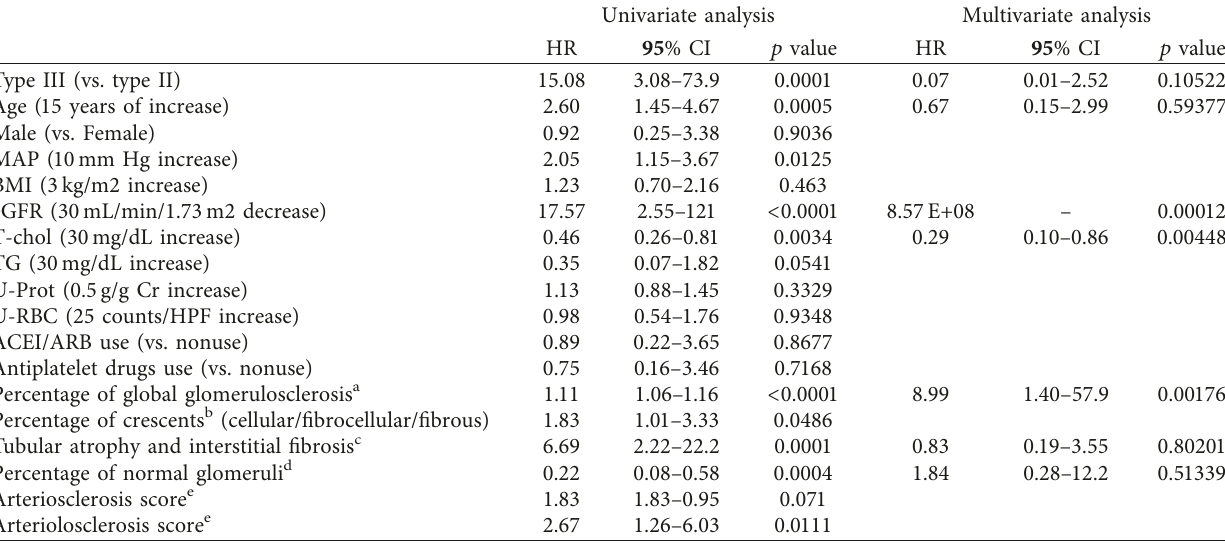
Figure 1: One-year renal survival in patients with type II and type III glomerulonephritis and crescents. Analysis of the 1-year survival rate using the Kaplan–Meier method shows that the renal prognosis of patients with type III glomerulonephritis and crescents was significantly worse ( p 0 . 0002). The solid line indicates the type II glomerulonephritis with the crescent group, whereas the dotted line indicates the type (cid:31) III glomerulonephritis with the crescent group. Table 3: Univariate and multivariate analysis of factors affecting renal prognosis between type II and type III rapid progressive